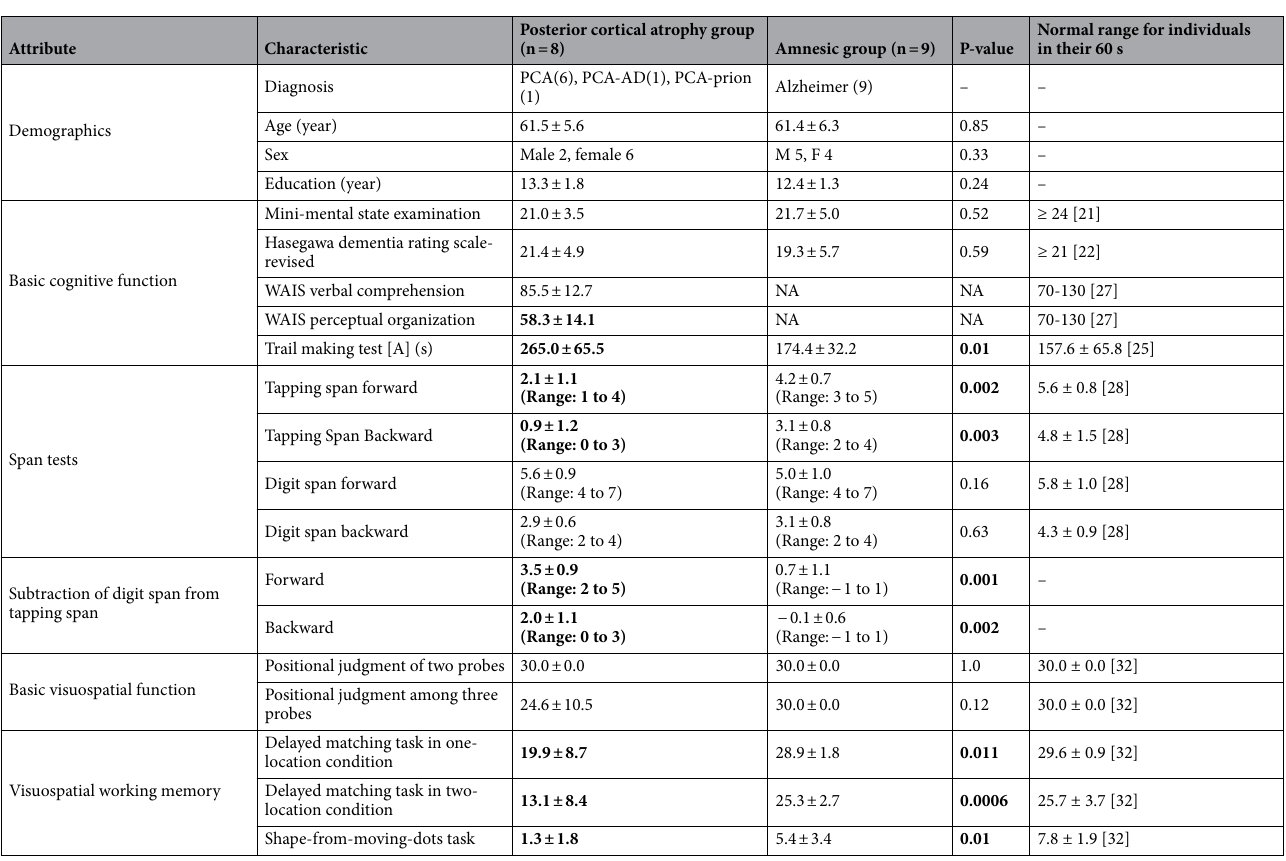
Table 1. Demographics and neuropsychological data between posterior cortical atrophy and amnesic groups. The p-values in bold text are significant (i.e., < 0.05). AD Alzheimer’s Disease, NA not applicable, WAIS Wechsler Adult Intelligence Scale. Values in bold font represent those with statistical significance.